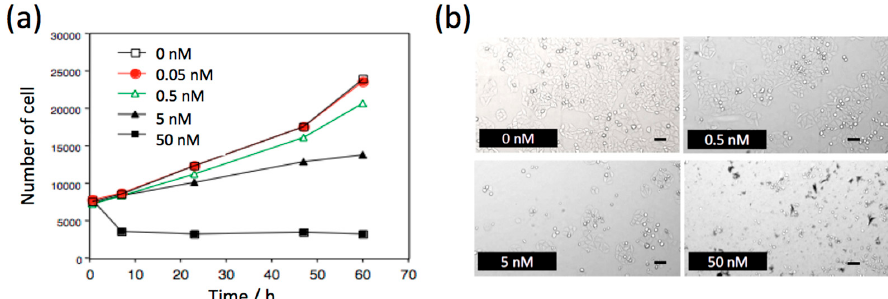
( b ) Bright field images of HeLa cells cultured after 60 h in the absence and presence of 0.5, 5, and 50 nM of QD1100. Scale bar: 100 µ